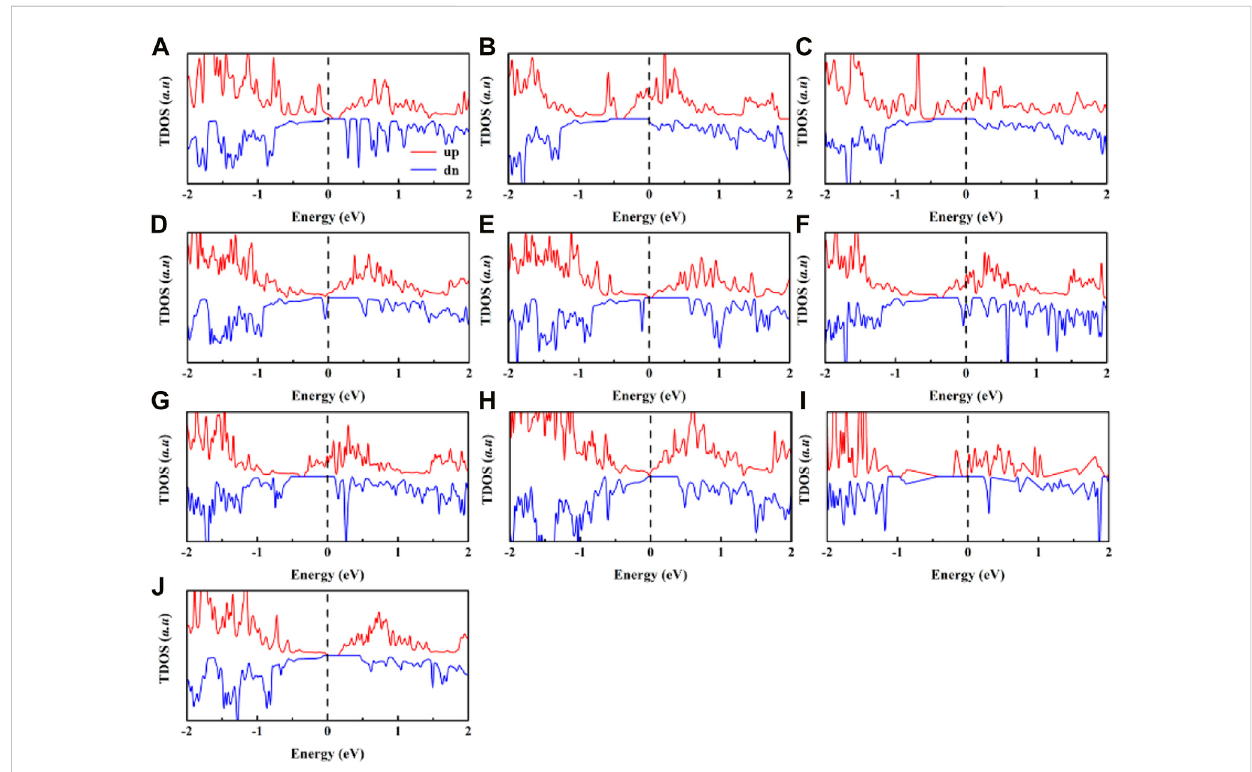
FIGURE 6 Spin-polarizedtotaldensity ofstates inthe (A) Cr 2 G 2 Te 6 @Sc, (B) Cr 2 G 2 Te 6 @Ti, (C) Cr 2 G 2 Te 6 @V, (D) Cr 2 G 2 Te 6 @Cr, (E) Cr 2 G 2 Te 6 @Mn, (F) Cr 2 G 2 Te 6 @ Fe, (G)